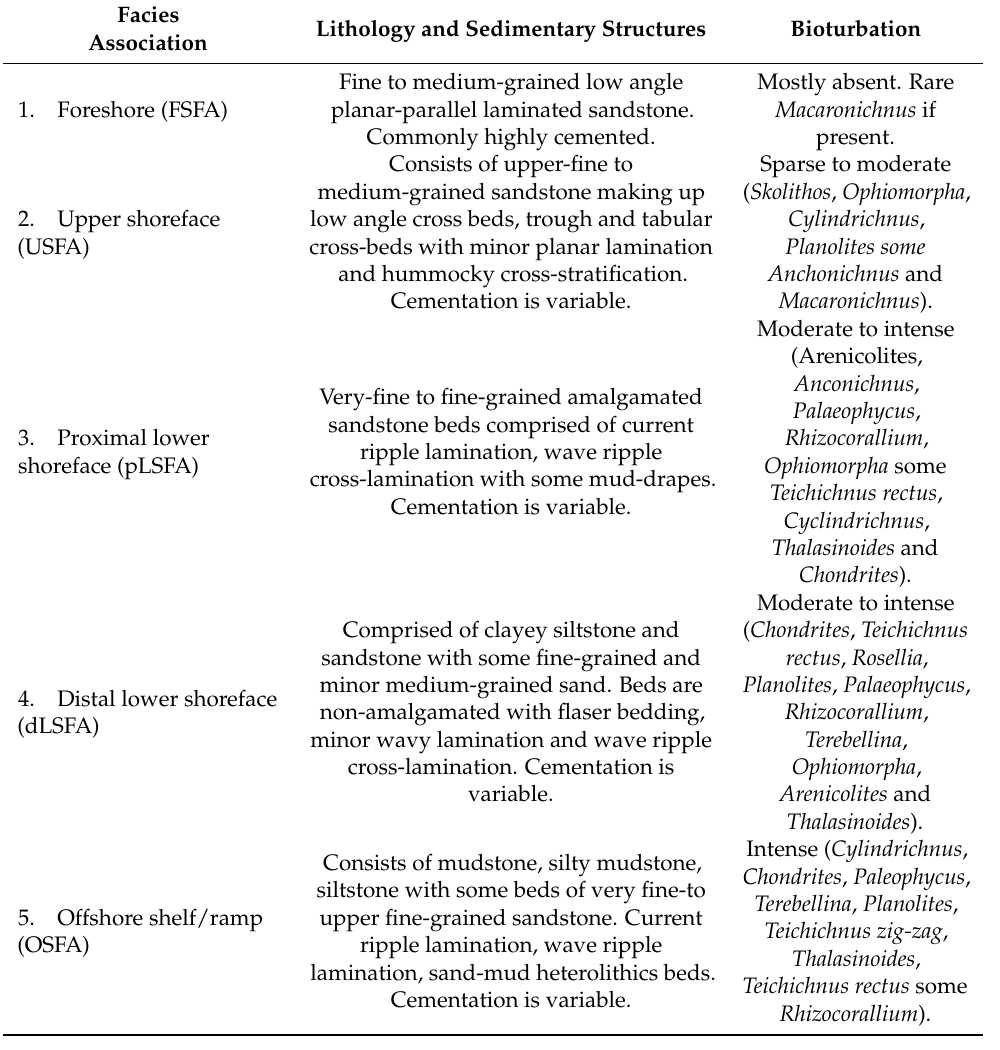
Table 1. Facies association for the Corallian sandstones.